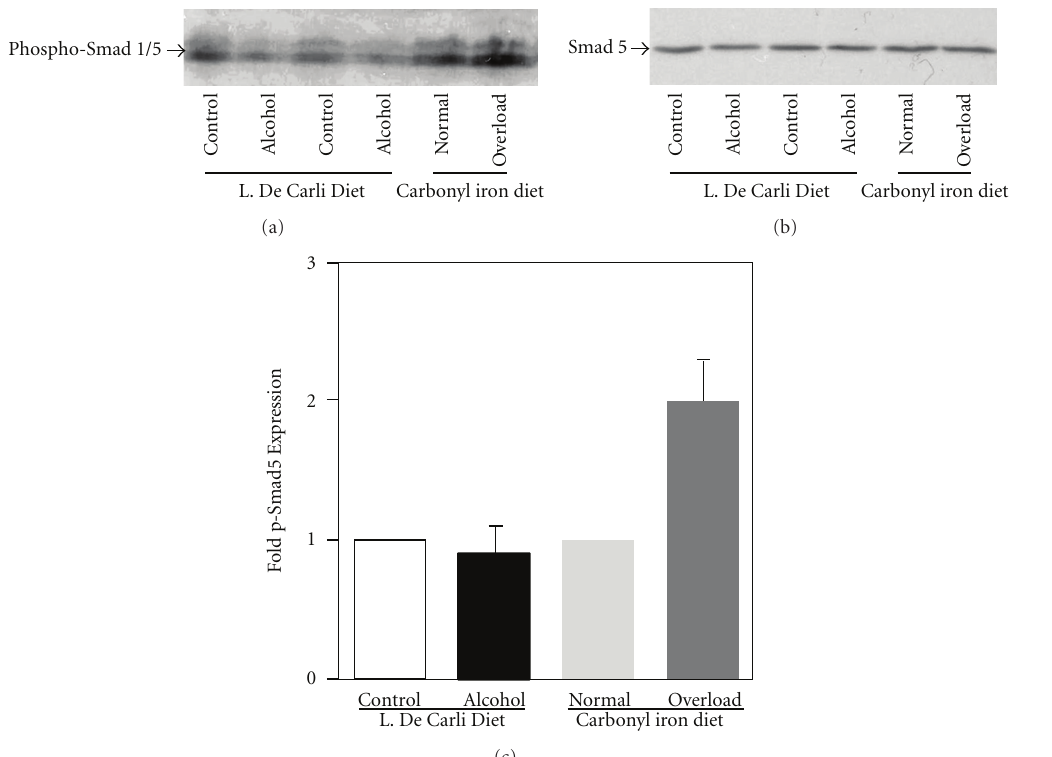
Figure 6: Activation of Smad1 and Smad5 . (a) The phosphorylation of Smad1 and Smad5 proteins in the liver lysates of mice fed with regular (control) or ethanol-containing (alcohol) Lieber-De Carli liquid diets, and of mice fed with diets containing 0.2% (normal) or 2% (overload) carbonyl iron was determined by western blotting employing an anti-phospho-Smad1/5 antibody, as described in Materials and Methods. (b) An antibody recognizing the total levels of Smad5 protein was employed as a control to confirm equal protein loading. (c) Autoradiographs from di ff erent experiments ( n = 3) were scanned by a densitometer, and phospho-Smad1/5 (p-Smad5) expression in each sample was quantified by normalizing to total Smad5 protein expression. Normalized phospho-Smad expression in alcohol or iron-fed mice was expressed as fold expression of that in the control